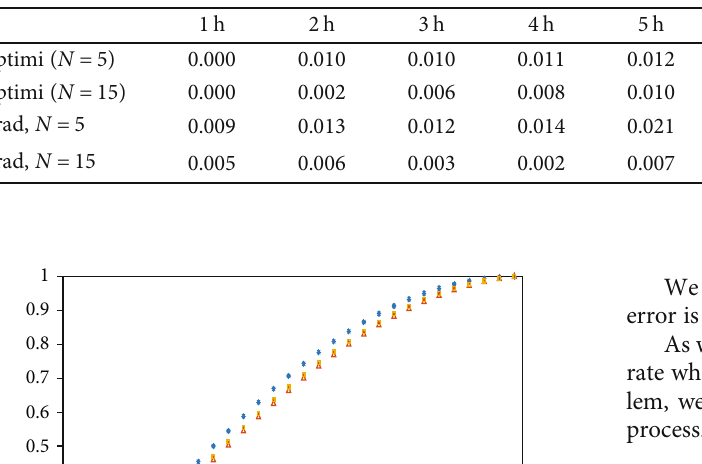
Table 2: Computational errors for example 1 where α = 0 : 9, h = 0 : 1 .